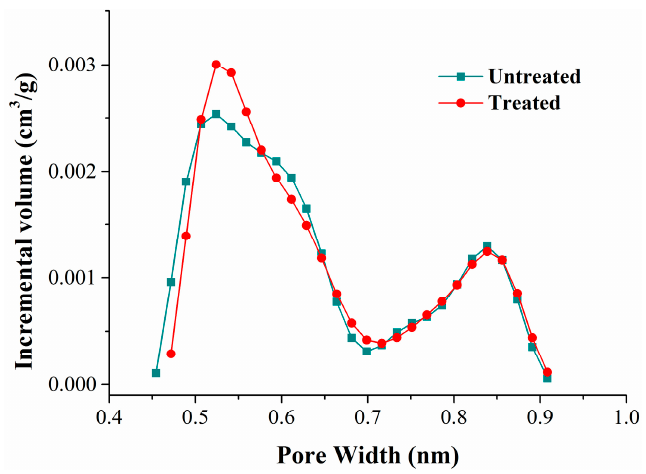
Figure 8. Pore volume distribution of carbon dioxide adsorption.